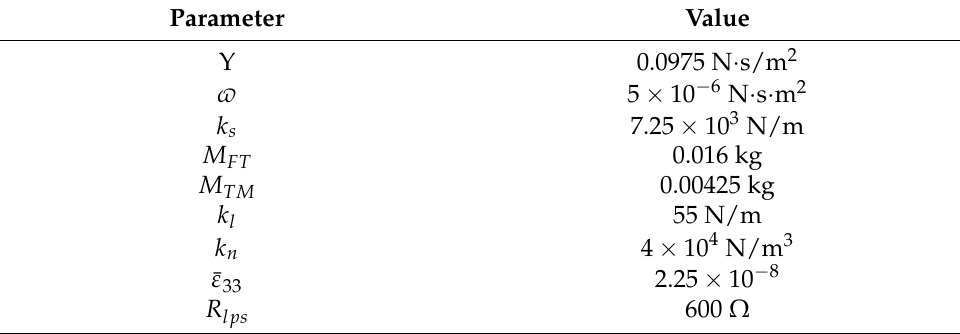
Table 2. Values of the unknown parameters obtained through